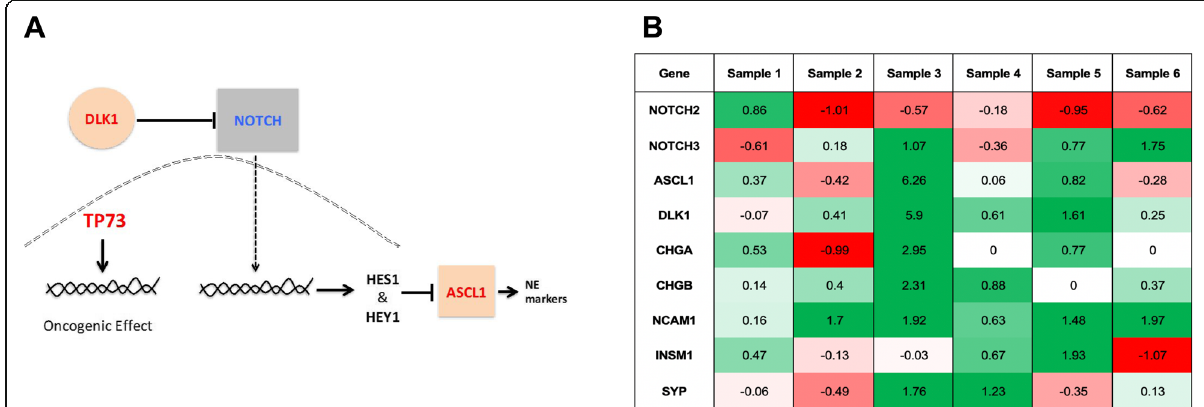
Fig. 2 A Overview of NOTCH and TP73 signaling. Arrows indicate activation, while blunt ends indicate inhibition. Note, upregulation of DLK1 inhibits NOTCH activity, while ASCL1 is inhibited by NOTCH. TP73 is upregulated in areas of neuroendocrine positivity and contributes to oncogenesis through an alternative pathway. B Heat map depicting differences in gene expression (log 2 fold-change) of genes in the NOTCH pathway in 6 paired B-SqCC samples. Red signifies lower expression, while green signifies heightened expression in neuroendocrine regions. In 5/6 samples, upstream inactivation (low expression of NOTCH2 or high expression of ASCL1, DLK1 or NOTCH3) with corresponding upregulation downstream neuroendocrine markers (CHGA, CHGB, NCAM1, INSM1 and SYP) is observed